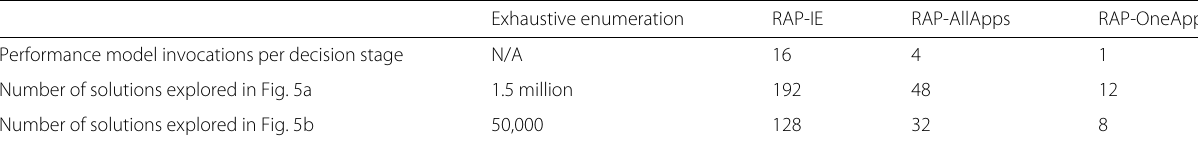
Exhaustive enumeration RAP-IE RAP-AllApps